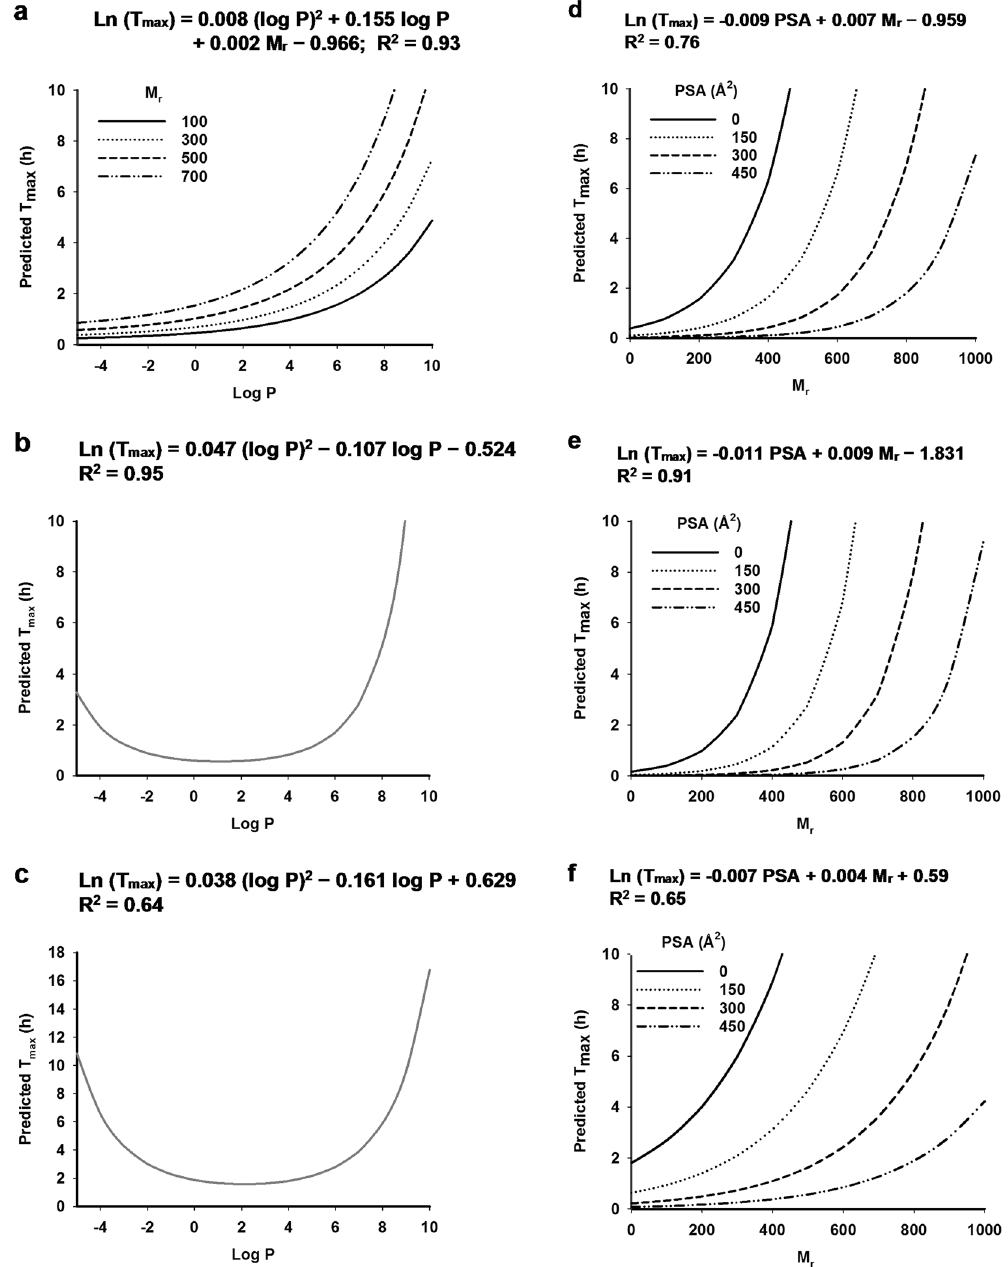
Figure 1. Prediction of T max by the predictive model. ( a ) The log P model in liquid, ( b ) semi-solid and ( c ) solid intakes. ( d ) The PSA model in liquid, ( e ) semi-solid and ( f ) solid